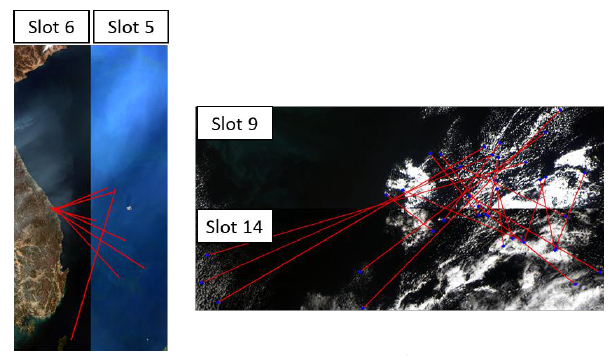
Figure 1. Feature matching result of ocean images Figure 3. Frequency matching result of ocean images